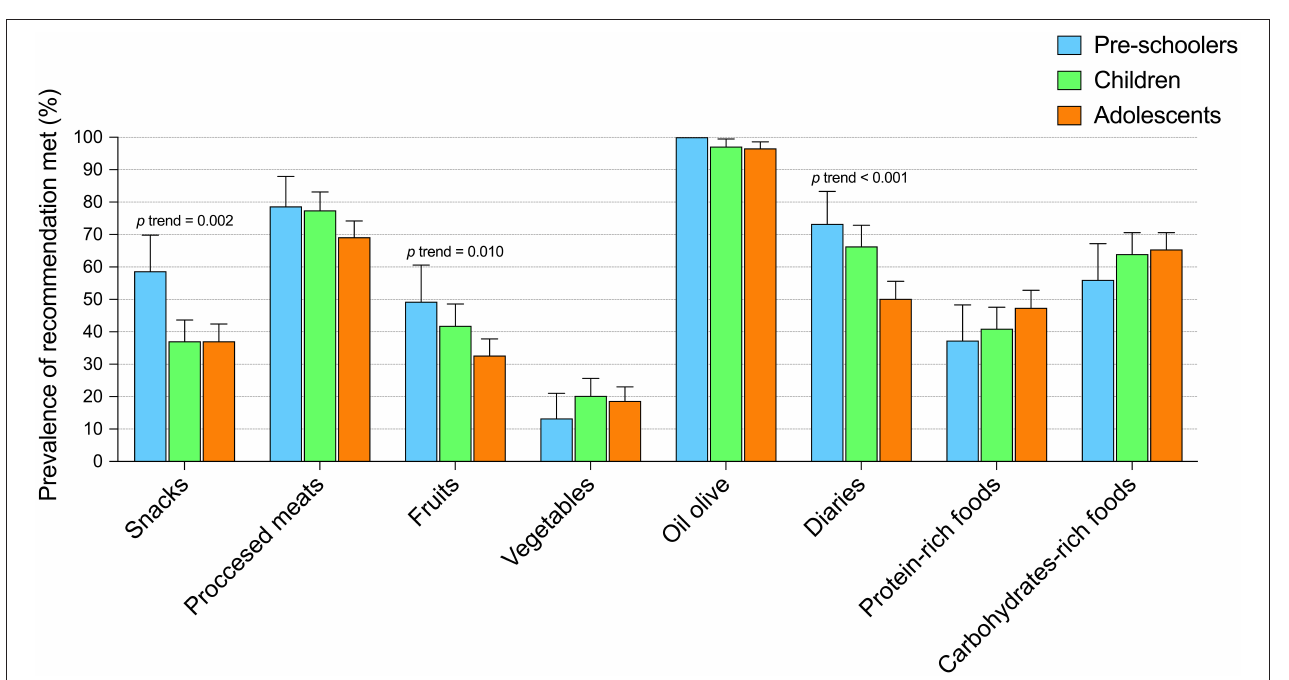
FIGURE 1 | Prevalence of meeting of the Food-Based Dietary Guidelines stratified by age